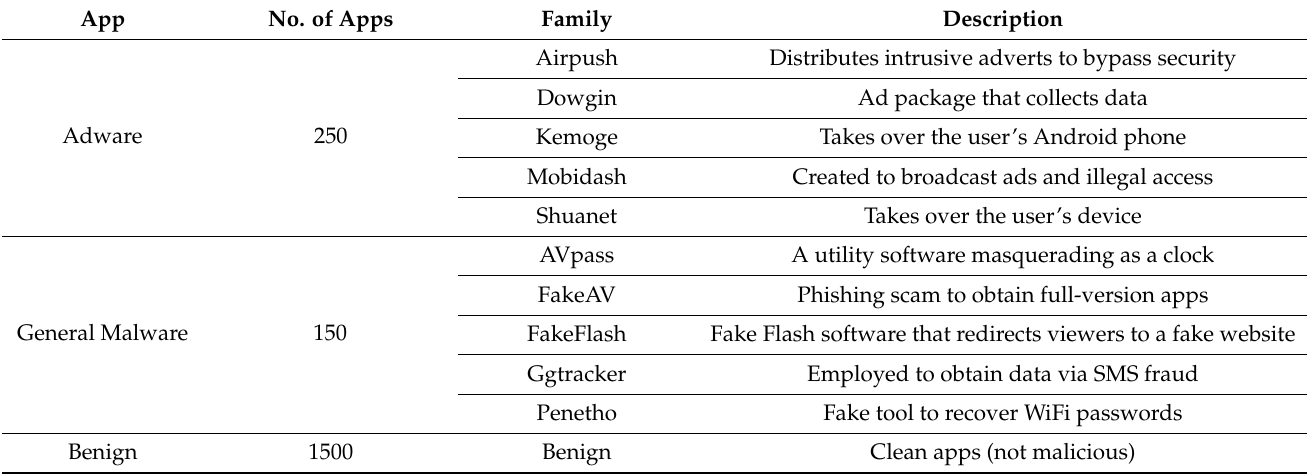
Table 2. Android Adware and General Malware Dataset (CIC-AAGM2017) (dataset